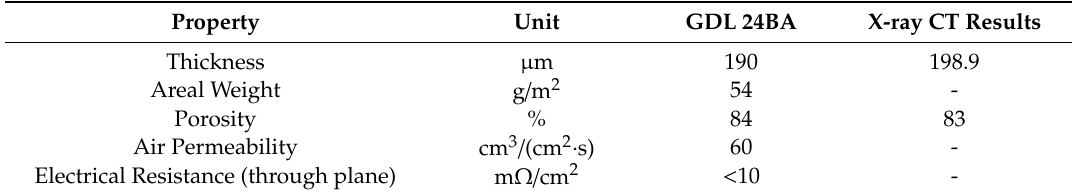
Table 1. Properties of SIG GDL24BA and X-ray CT